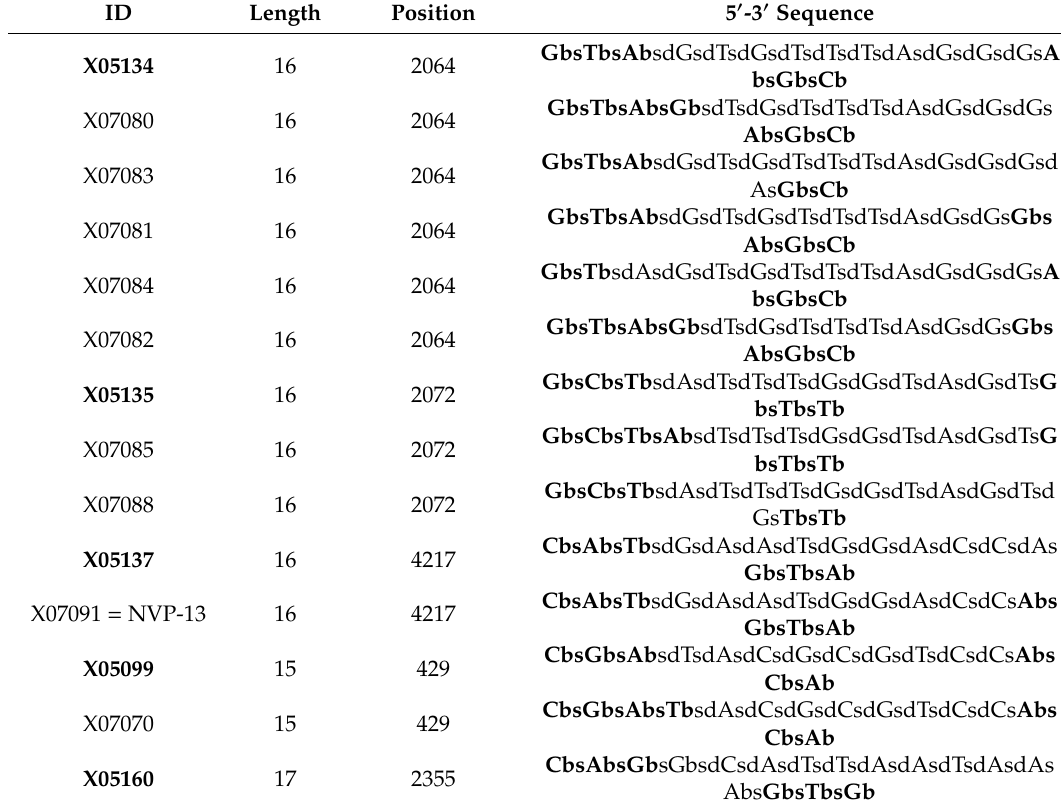
Table 2. LNA-Modification of parental sequences. Parental sequences with a standard modification of three flanking LNAs were modified with varying numbers of LNAs at the 5‘ and 3‘ wing yielding derivates. X05134: X07080-X07084, X05135: X07085, X07088, X05137 : X07091 = NVP-13 , X05099: X07070, X05160: X07095, X05082: X07064 and X07065. Ab, Cb, Gb and Tb = LNA, dA, dC, dG and